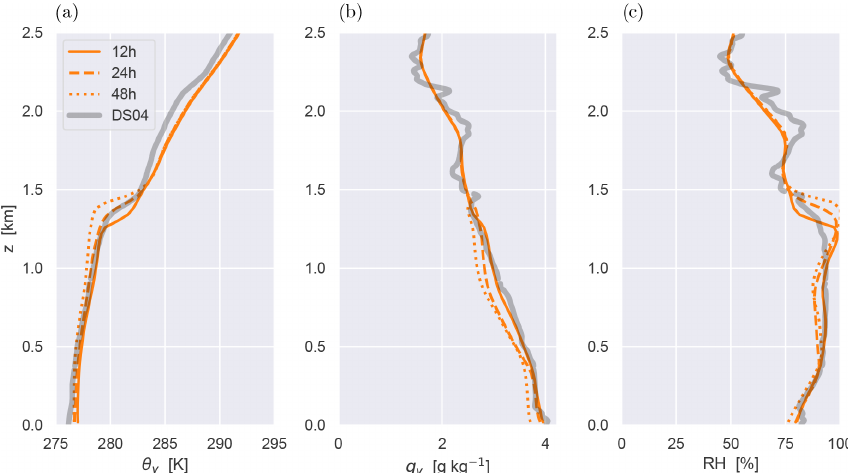
Figure 7. Domain-averaged vertical profiles during the control experiment. (a) Virtual potential temperature θ v . (b) Water vapor specific humidity q v . (c) Relative humidity RH. The DS04 dropsonde sounding is shown in grey. Three subsequent time points are